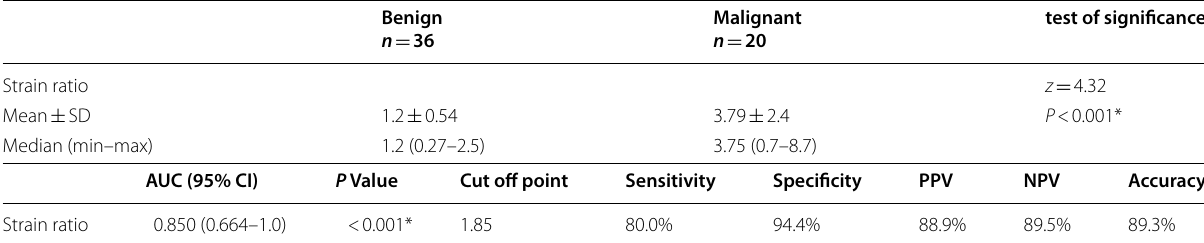
Table 3 Validity of strain ratio in differentiating benign and malignant lesions